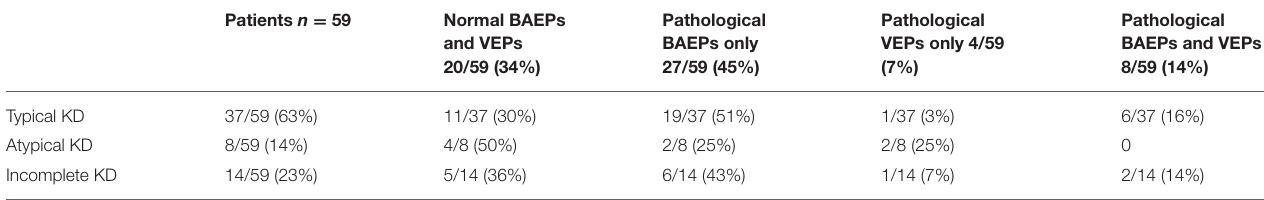
TABLE 1 | BAEPs and VEPs findings (normal or pathological) were divided in three groups of KD (typical, atypical and incomplete KD).